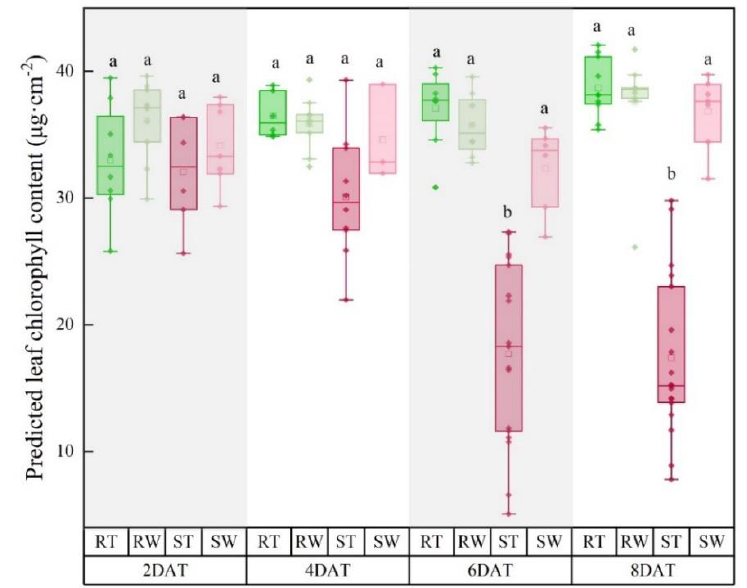
Figure 3. Impact of glyphosate stress on leaf chlorophyll content on 2, 4, 6, and 8 days after treatment (DAT). Within the same sampling point, any two bars with a common letter are not statistically significant according to ANOVA (Holm − Bonferroni post hoc test, p > 0.05). RT, RW, ST, and SW plants are represented by green, light green, red, and light red.